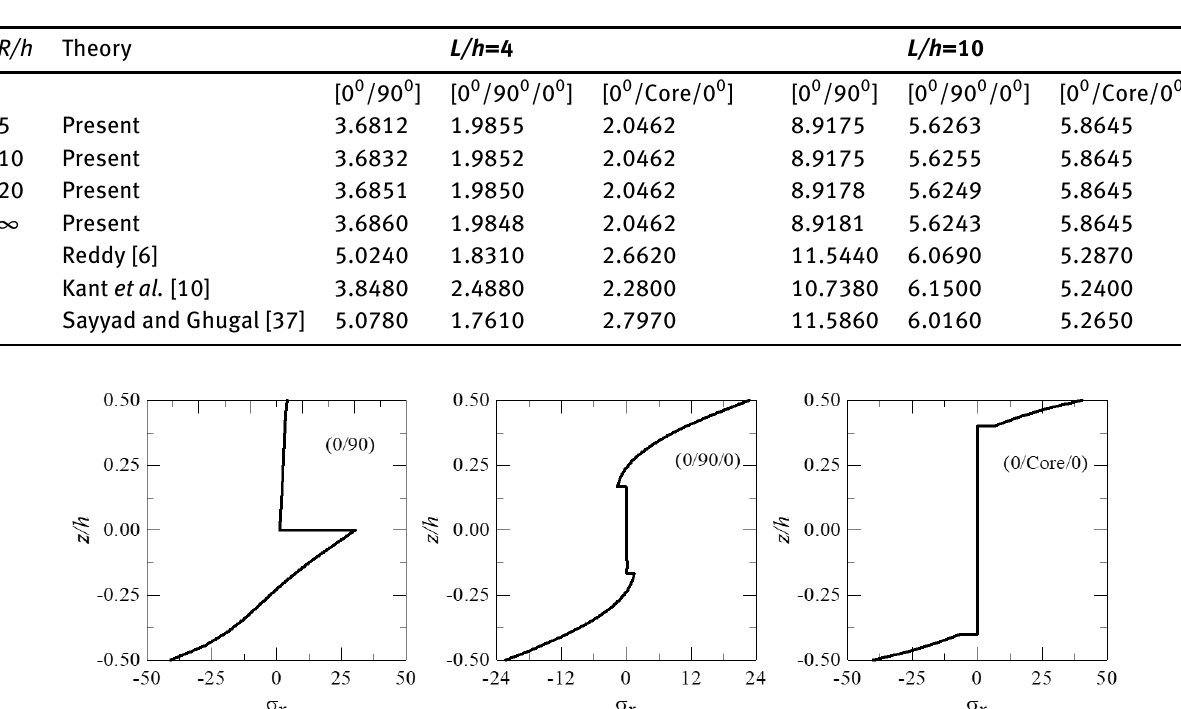
Table 5: Normalized shear stress ( ¯ τ xz ) of simply-supported laminated composite and sandwich curved beams.